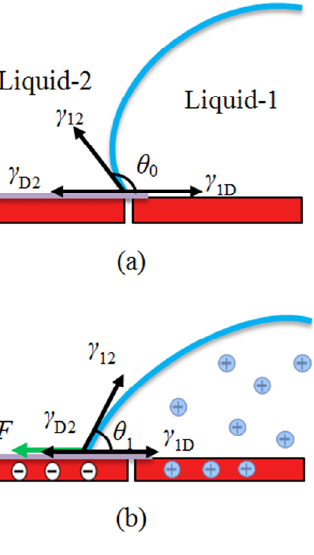
Figure 2. Electrowetting effect mechanism in the device: ( a ) Initial state; ( b ) External force reaching to balance.